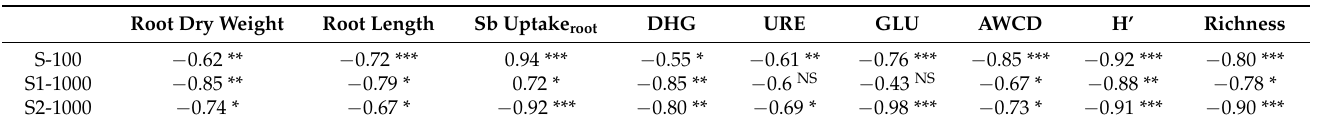
Figure 2. Dehydrogenase activity in amended and unamended Sb-polluted SA and SB soils. Average values (histograms) and standard errors (bars) are reported. T0, T1 and T2 refer to MSWC addition, i.e., 0, 1 and 2%, respectively. For each soil (SA and SB) and Sb concentration level, different letters denote significant differences between treatments (Tukey–Kramer test; p < 0.05). Asterisks denote significant differences between SA-100 and SB-100, and between SA-1000 and SB-1000 (Student t-test; p < 0.05). Table 2. Pearson correlations between the most labile Sb fraction (i.e., Sb extracted in step 0 of SEP), soil biochemical parameters, root dry weight, root length and Sb uptake by the roots of triticale plants.